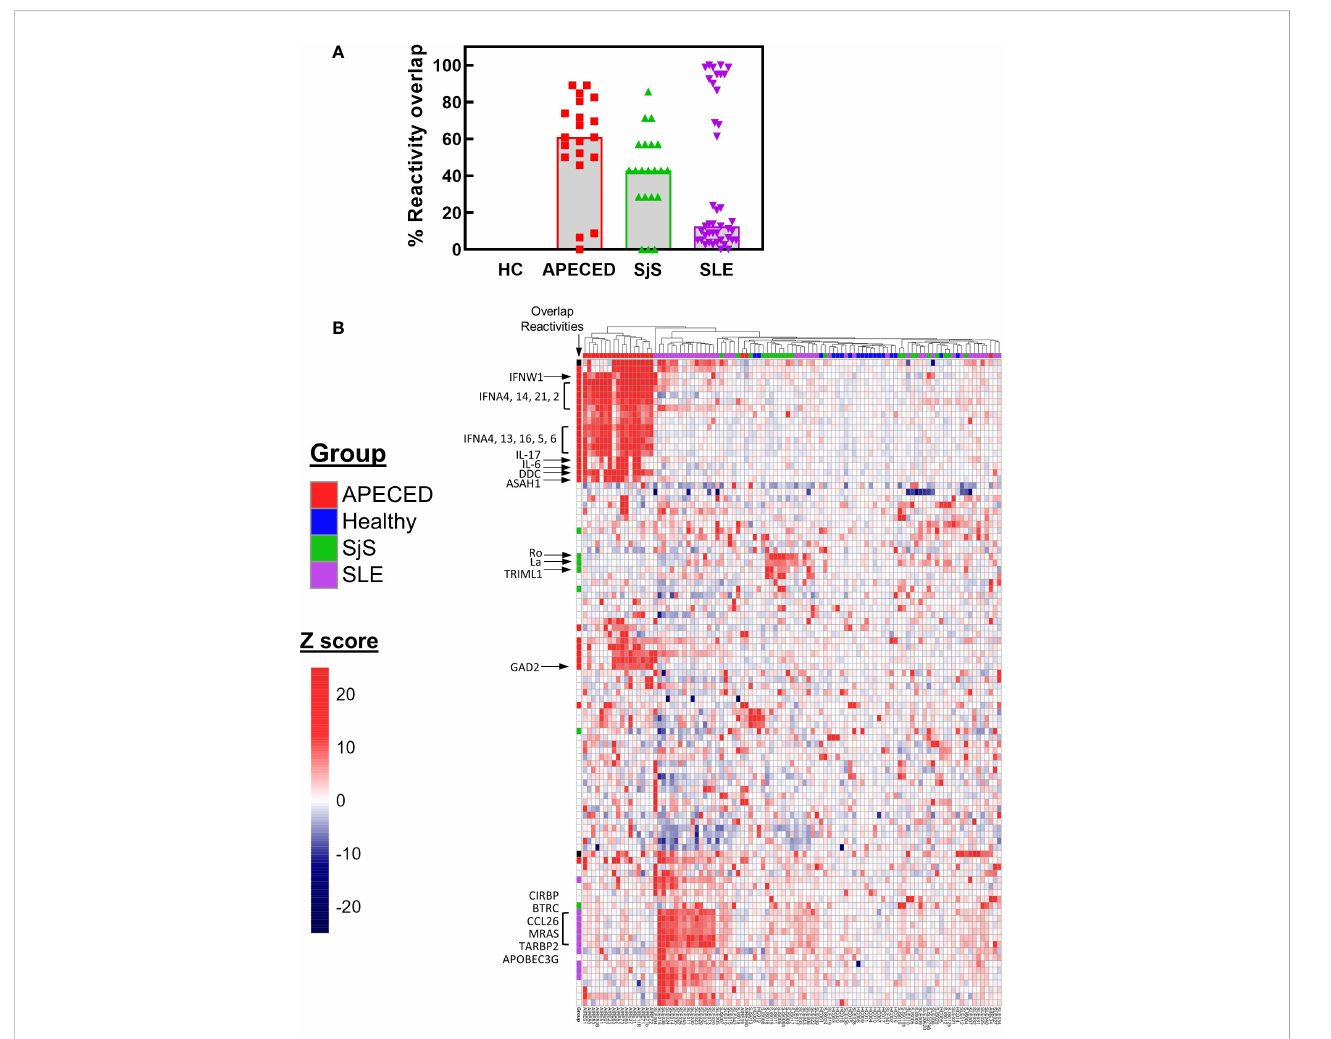
FIGURE 3 ProtoArray analysis of autoimmune patients reveals that autoantibody repertoires differ in the number of reactivities within and between groups. (A) The amount of overlap in the ProtoArray reactivity for each subject with other subjects in each group is shown. Overlap was considered for common reactivities with a Z >5 in 30% of the subjects for each group. (B) The highest 100 reactivities by variance are presented in a hierarchal clustered heat map. The heat map is colored by Z score and each column represents an individual subject with the group identi fi ed by the color bar above the column. Several key canonical reactivities are identi fi ed with arrows. Markings in the column labeled ‘ Overlap ’ identify which reactivities had a high degree of overlap for each group (Z >5 in 30% of the subjects for each group). APECED, autoimmune polyendocrinopathy – candidiasis – ecto-dermal dystrophy; HC, healthy control; SLE, systemic lupus erythematosus; SjS, Sjogren ’ s